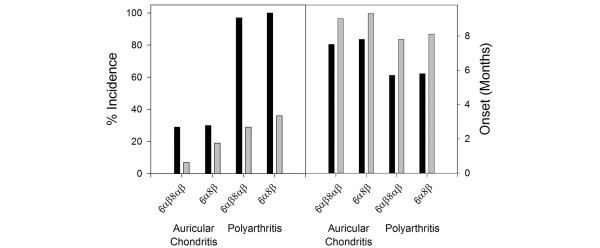
Incidence and onset of spontaneous polychondritis in female versus male DQ6α8β transgenic expressing mice. The onset of auricular chondritis and polyarthritis was determined by visual inspection and was confirmed by histological analyses as described in Table 1. Females (black shading) were more highly susceptible to both auricular chondritis and polyarthritis, and displayed clinical disease earlier than males (grey shading).